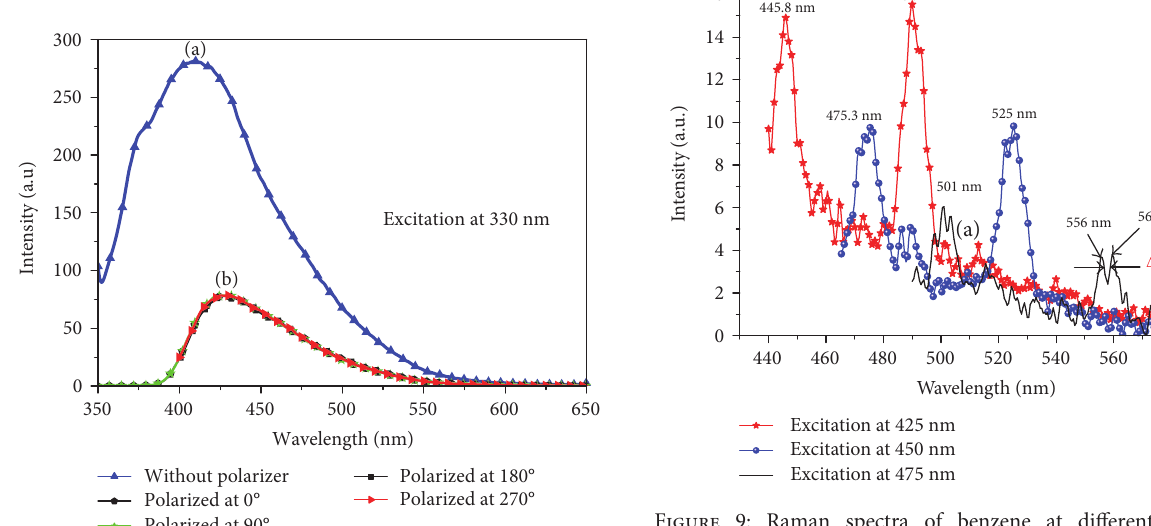
Figure 9: Raman spectra of benzene at di ff erent excitation wavelengths. (a) is black